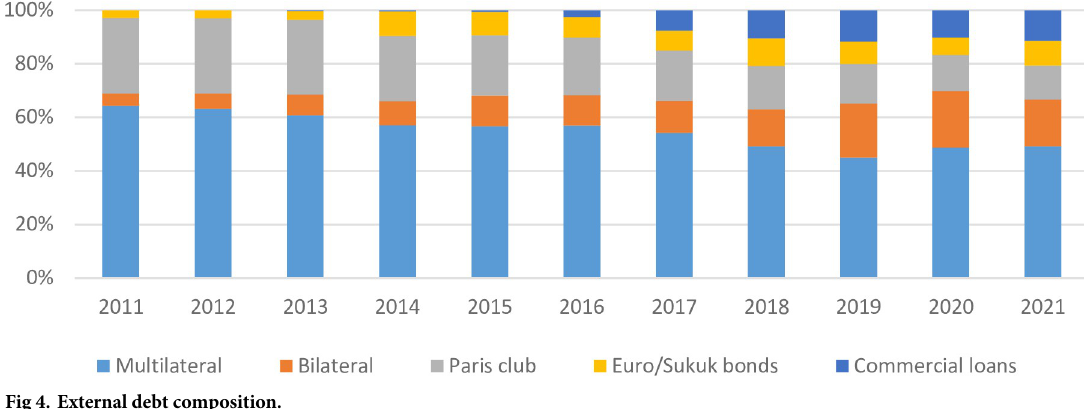
Fig 4. External debt